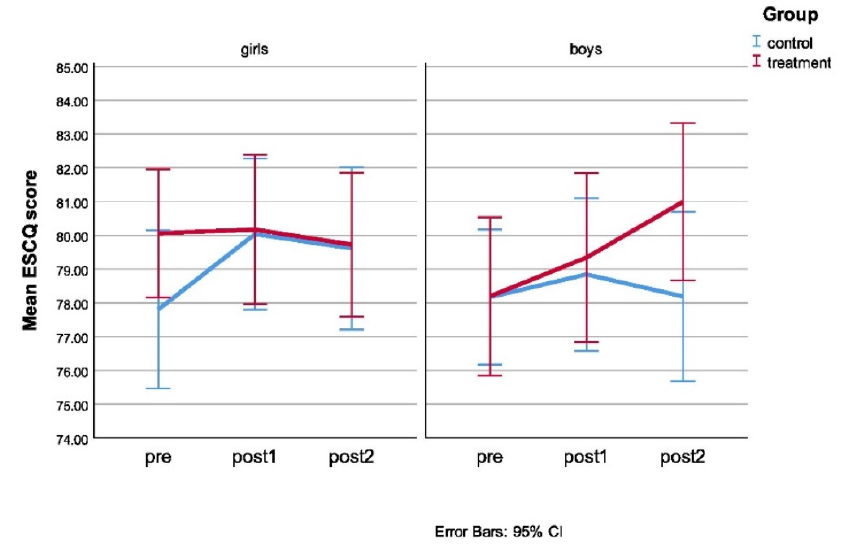
Figure 1. Mean ESCQ-C scores as a function of gender and group placement measured at different timepoints .